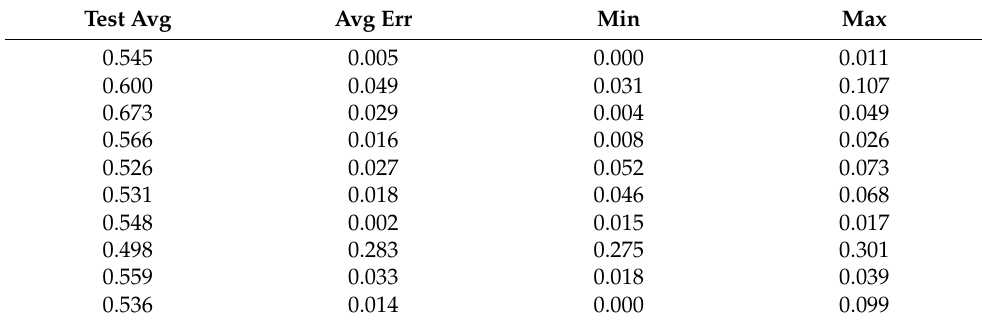
Table A146. Set 2, trials 41–50 data (actual PR value).